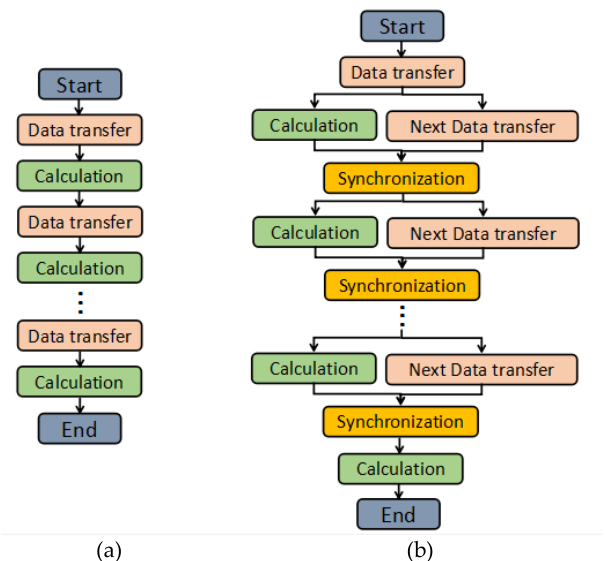
Figure 4. ( a ) General data transfer mode; ( b ) Double cache data transfer mode. Table 1. Pseudo-code of double cache data transfer